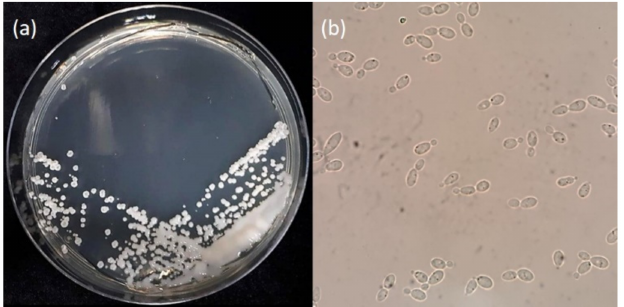
Figure 1. The morphology of G. antarctica grown on Yeast Peptone Dextrose (YPD) agar at 12 ◦ C for 10 days. ( a ) The presence of exopolysaccharides on the surface of the yeast cells; ( b ) G. antarctica cells observed under a light microscope (40 ×